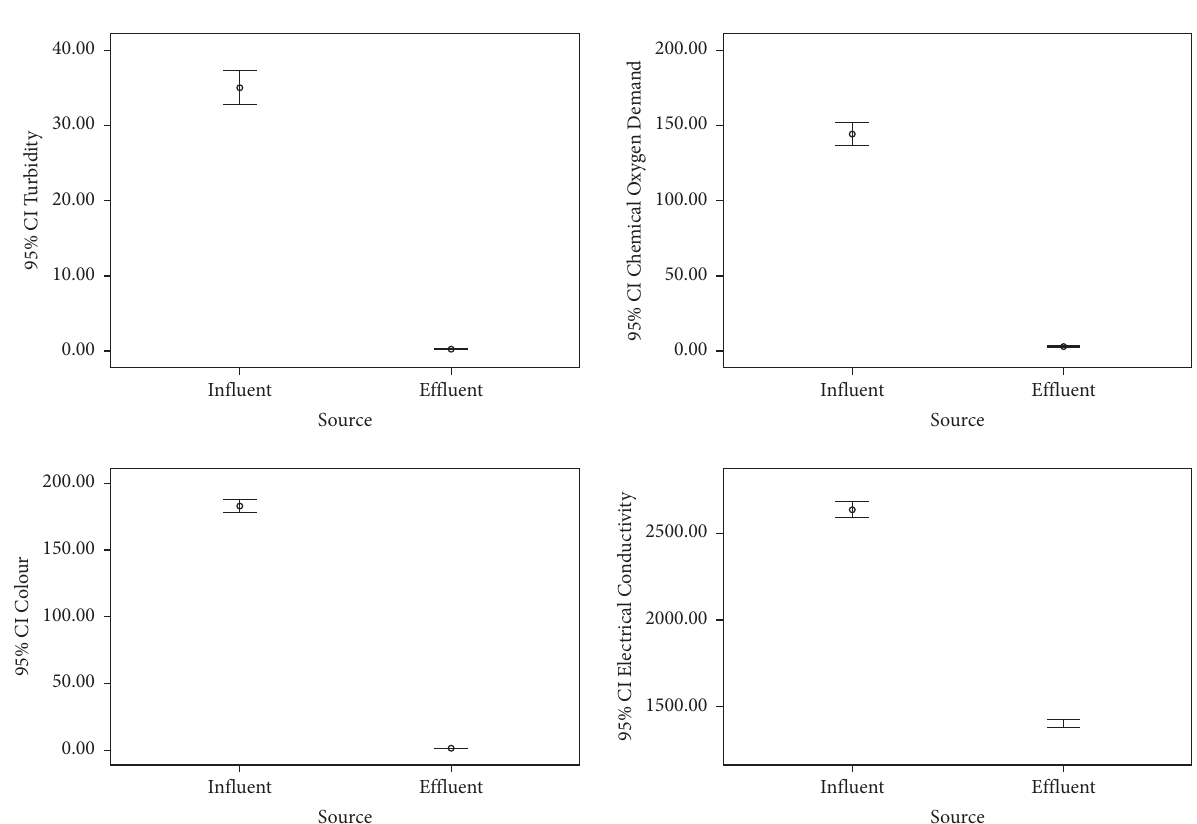
Figure 6: Output of infuent-efuent values showed signifcant diference for some physicochemical parameters. Table 8: Mean results for the analyzed heavy metal concentrations of Mudor and recycled efuent. Mudor WWTP efuent Recycled Metal N